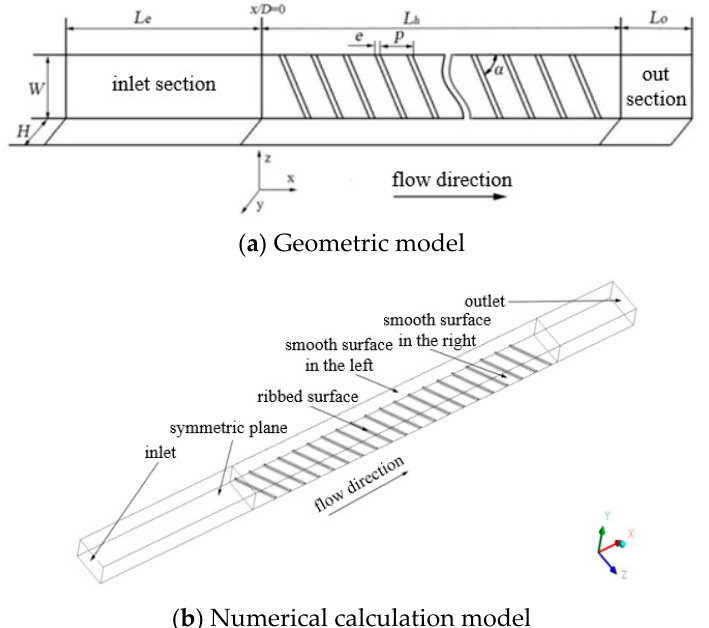
Figure 1. Schematic diagram: ( a ) geometric model and ( b ) numerical calculation model.